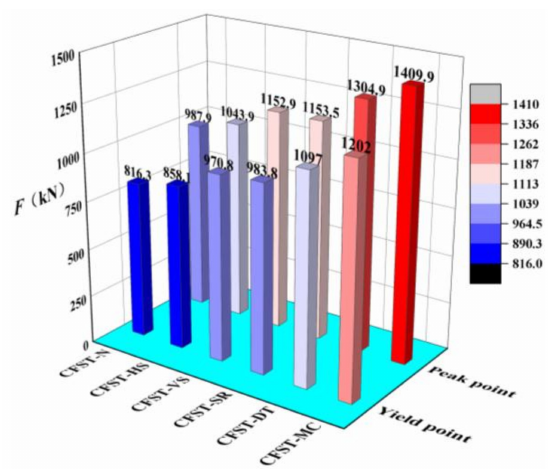
Figure 10. Bar graph of bearing